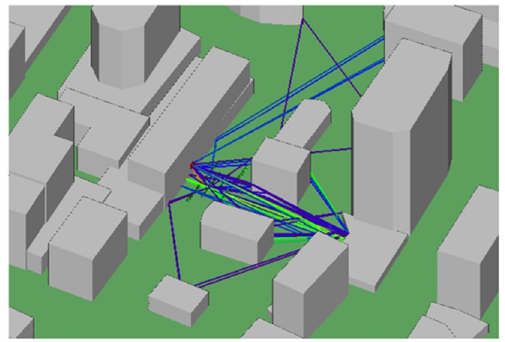
Figure 1. Ray-tracing simulation in Urban CanyonChannel model.